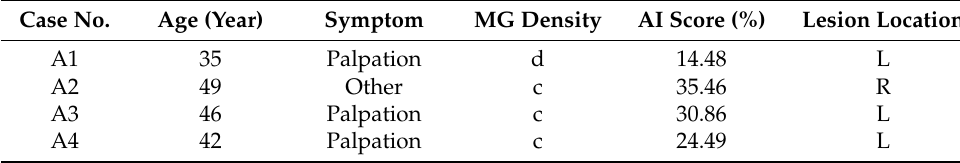
Table 7. Invisible cases in radiologist and concordant cases only in AI analysis.